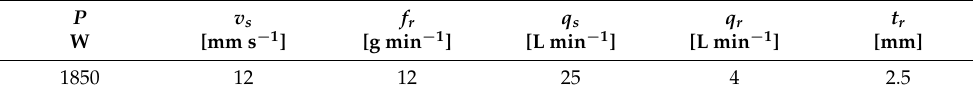
Table 2. Process parameters used in the deposition of the deposited wall from which specimens were obtained. P is the laser power, v s is the scanning speed, f r is the powder feeding rate, q s is the shielding gas flow rate, q r is the powder carrying gas flow rate, and t r is the laser spot size diameter. P